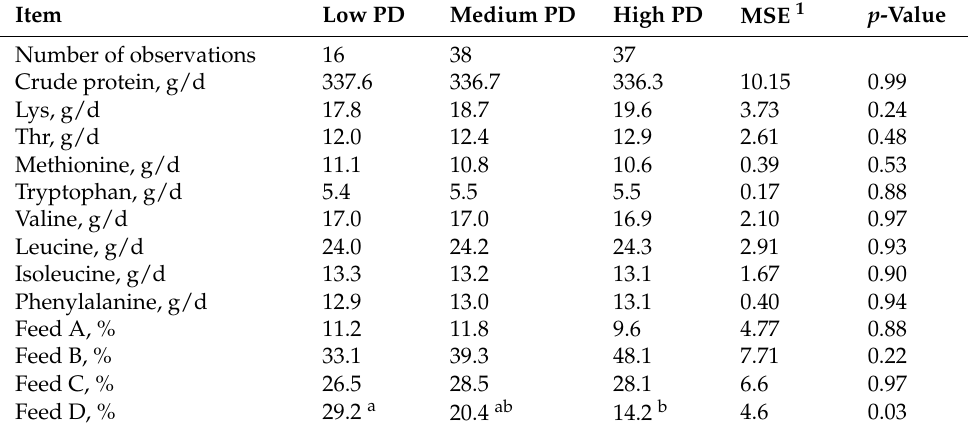
Table 3. Average nutrient intake in growing barrows (35–60 kg body weight) fed daily tailored diets varying lysine (Lys) and threonine (Thr) levels, and clustered in low (167 g/d), medium (191 g/d), and high (213 g/d) protein deposition (PD).